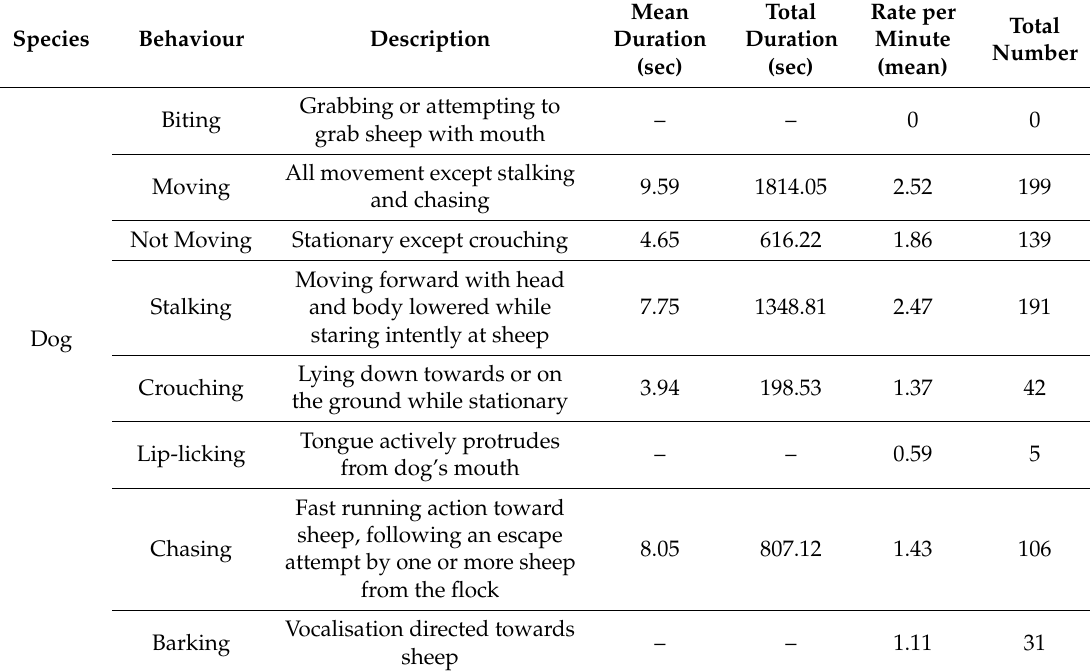
Table 1. Ethogram and descriptive statistics summarising the dog and sheep behaviours coded in the current